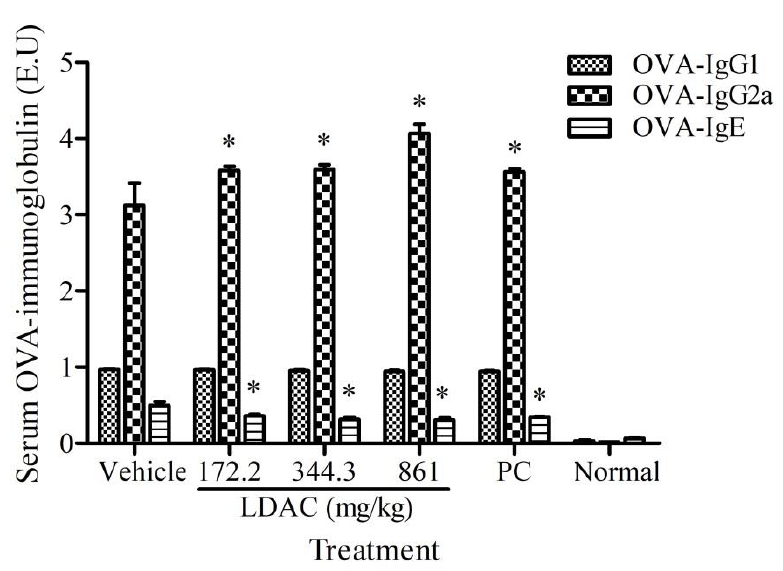
Figure 3. E ff ect of LDAC on serum ovalbumin (OVA)-IgG1, OVA-IgG2a, and OVA-IgE secretion. The OVA-immunized mice were administered with LDAC (172.2, 344.4, 861 mg / kg) and positive control (PC, 633.5 mg / kg) for 8 weeks. The serum OVA-IgG, OVA-IgG2a, and OVA-IgE were analyzed using ELISA assays. All data were presented as mean ± SD. * p < 0.05 compared to vehicle control. Normal group received only sterile water.